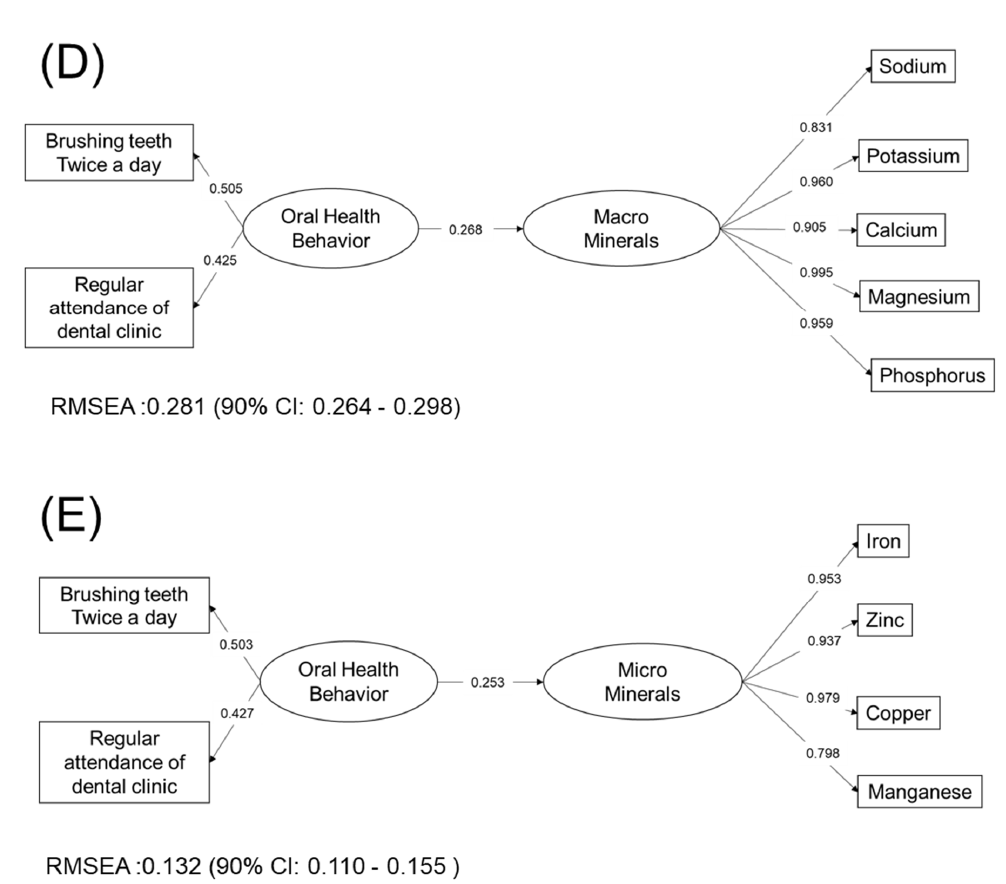
Figure 3. Structural equation modeling of oral health behavior and nutrition intakes: ( A ) three macronutrients; ( B ) water-soluble Vitamins; ( C ) fat-soluble vitamins; ( D ) macro minerals; and ( E ) micro minerals.